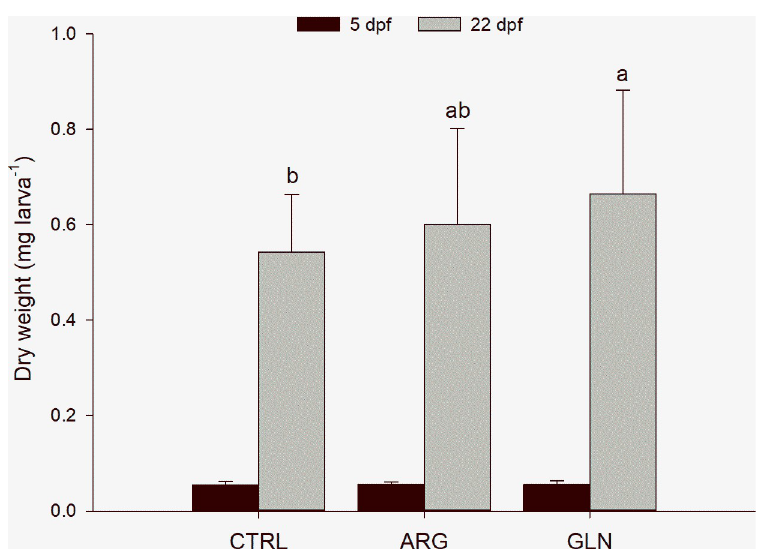
(S1A Fig). In addition, the effects of the early supplementation in the larval FAAs profile were maintained until the end of the experiment (22 dpf) (P = 0.000 and 0.000 for ARG and GLN, respectively) (S1B Fig). As expected, amino acid supplementation also affected the pool of total indispensable and dispensable amino acids in both, embryos, and larvae. Arginine supplementa- tion (indispensable amino acid) significantly increased the total IAA pool, while glutamine sup- plementation (dispensable amino acid) significantly increased the total pool of DAA.